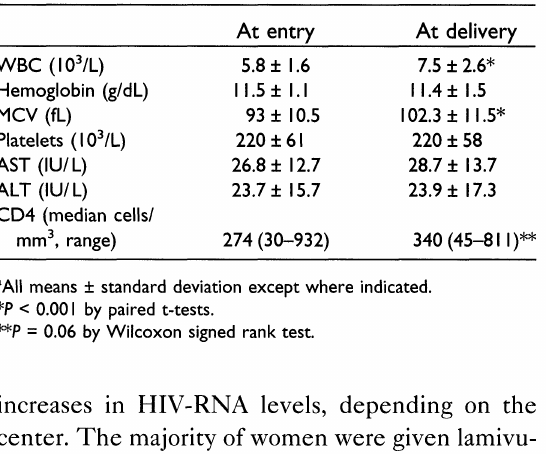
TABLE 2. Maternal laboratory values (n